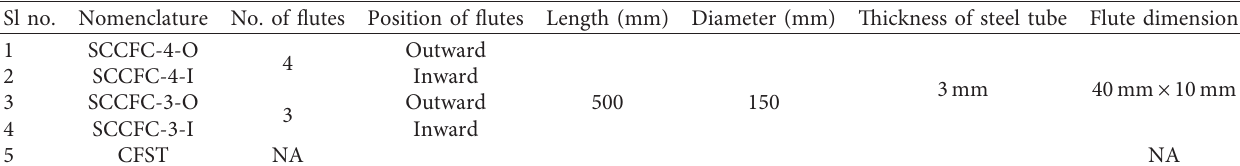
Figure 1: Cross-section details: (a) 3-outward fluted section; (b) 3-inward fluted section; (c) 4-outward fluted section; (d) 4-inward fluted section. Table 1: Details of the specimen.